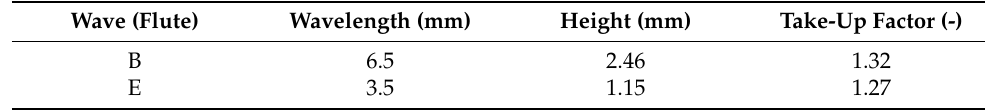
Table 2. Geometric parameters of cardboard flutes.